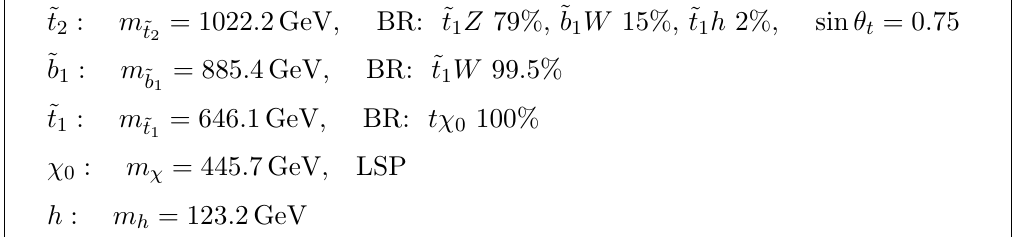
Table 1 . Benchmark point: mass spectrum and branching ratios. For this point, we set tan (cid:12) = 15, (cid:22) = 800 GeV, and all other masses (including the gluino mass) to 2 TeV. relevant particles, generated with SUSY-HIT [26], are listed in table 1. For this spectrum, we simulated 13 TeV LHC collision events with the Madgraph5 aMC @ NLO package [56], with detector simulation using Delphes-3.2.0 [57].